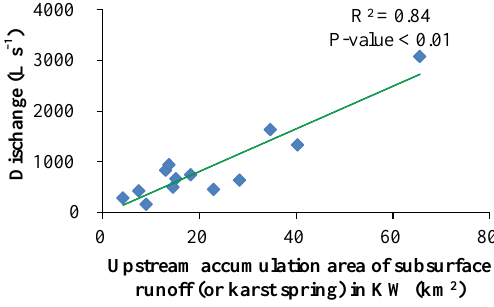
Figure 6. Correlation between the discharge of subsurface runoffs (or karst springs) and the upstream watershed area in karst water- sheds